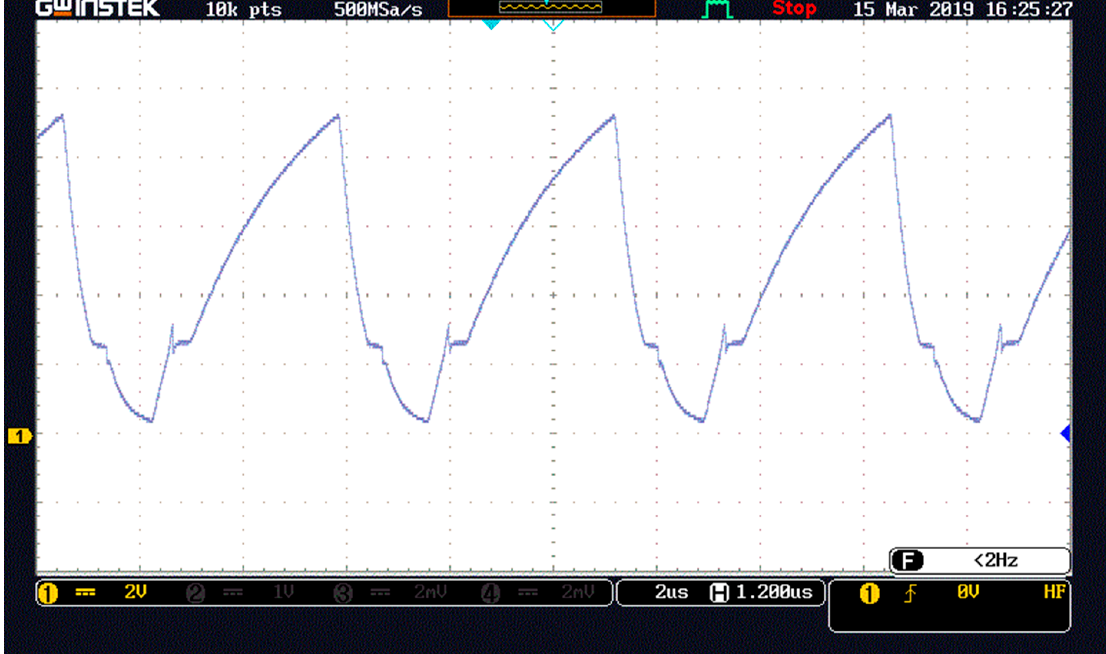
Figure 15. Inductance voltage V Lb waveform.